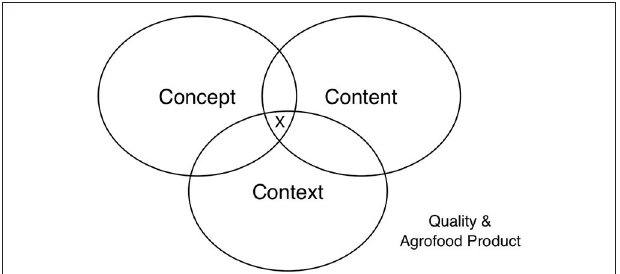
FIGURE 1 | A diagrammatic representation of interaction space between concept, content, and context perspectives of quality of a given agrofood product. The interaction between the three, indicated with “X,” that is, concept vs. content vs. context perspectives of